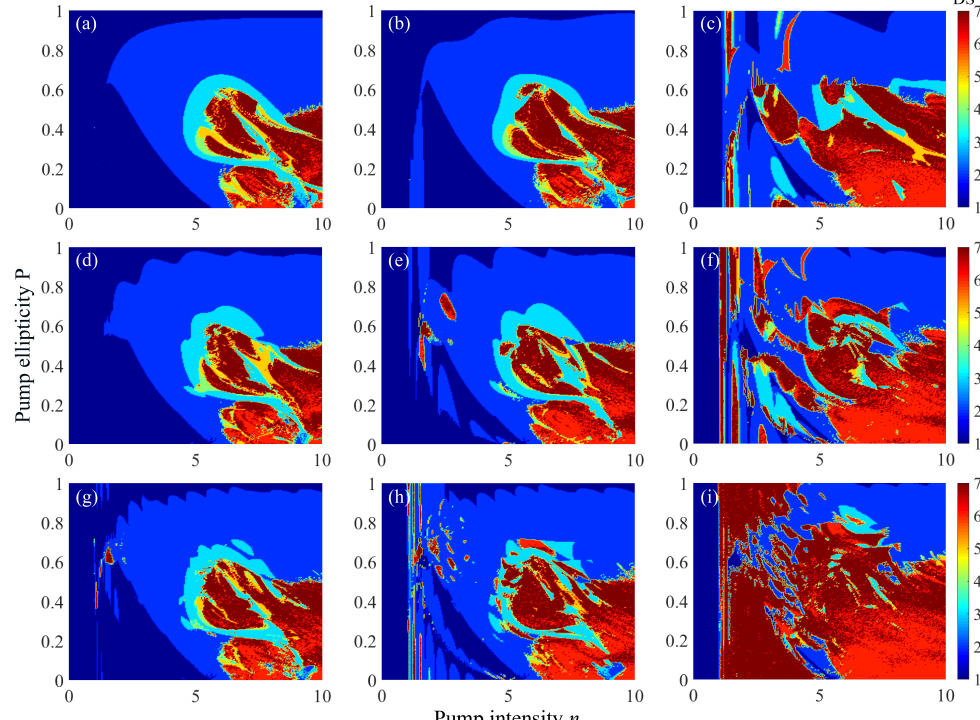
Figure 6. Mapping of the different dynamic states of spin-VCSEL with optical feedback in the parameter space of ( η , P ), in which ( a ) τ = 0.1 ns , k = 0.1 ns − 1 ; ( b ) τ = 0.4 ns , k = 0.4 ns − 1 ; ( c ) τ = 0.4 ns , k = 2 ns − 1 ; ( d ) τ = 0.8 ns , k = 0.4 ns − 1 ; ( e ) τ = 0.8 ns , k = 0.8 ns − 1 ; ( f ) τ = 0.8 ns , k = 2 ns − 1 ; ( g ) τ = 2 ns , k = 0.4 ns − 1 ; ( h ) τ = 2 ns , k = 0.8 ns − 1 ; ( i ) τ = 2 ns , k = 2 ns − 1 . The other parameters are the same as those given in the preceding discussion. 1: steady state; 2: P1; 3: P2; 4, 5: multi-period; 6, 7: chaos